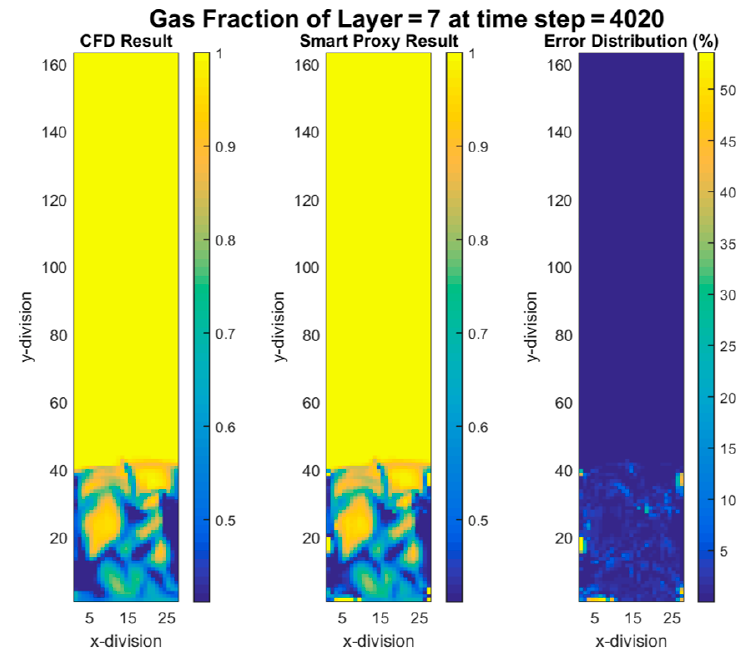
Figure 20. CFD and cascading smart proxy results for gas volume fraction at K = 7 cross-sectional plane and time step = 4020.